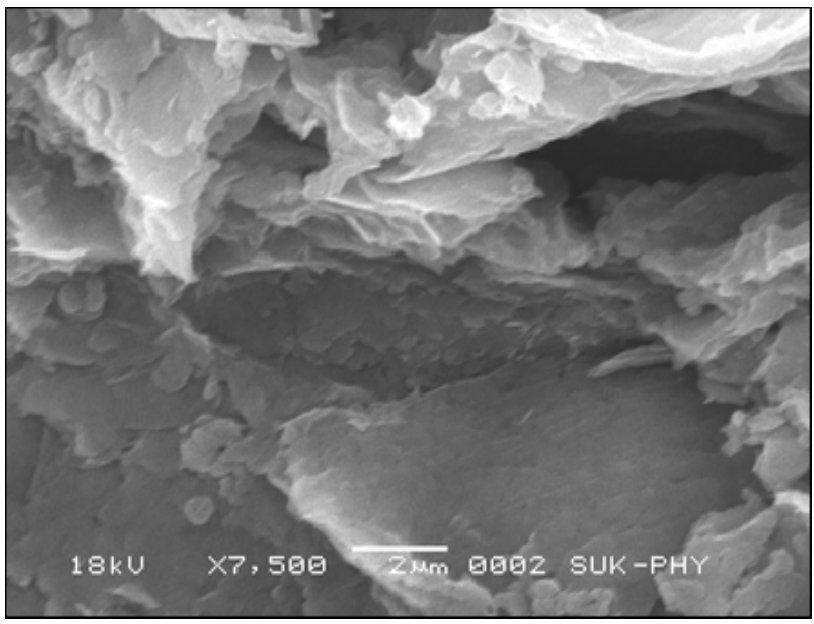
Figure 6. SEM image of castor oil-emitted powder.